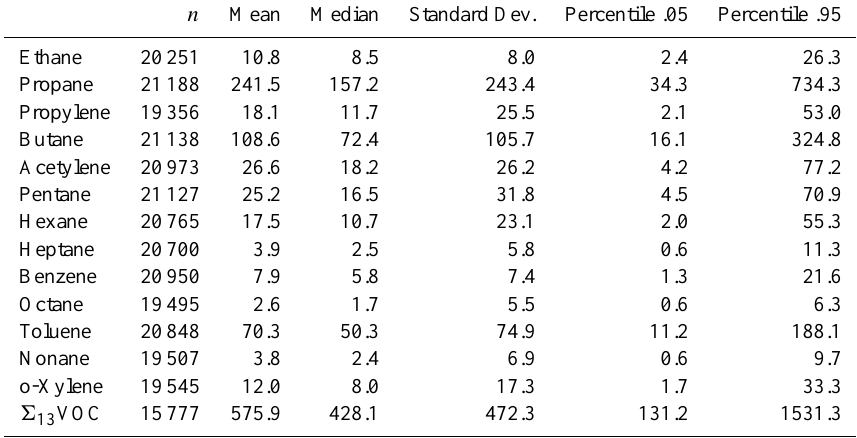
Table 1. Descriptive statistics of VOC measurements from 2000 to 2007 for each of the quantified species. Concentrations in ppbC.